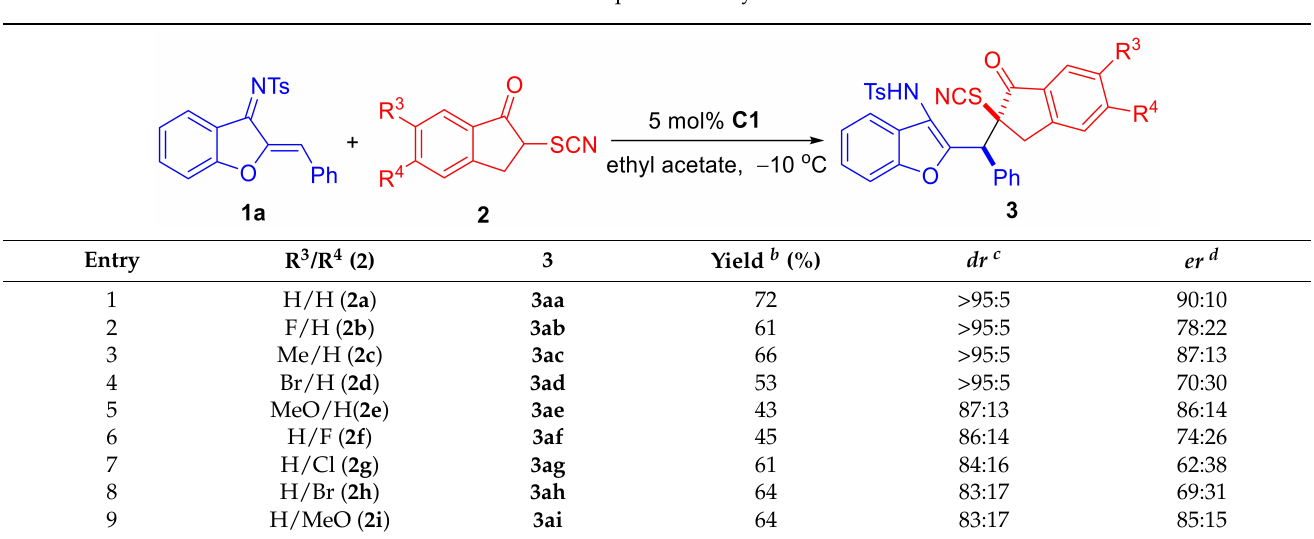
Table 3. Substrate scope of α -thiocyanoindanones a .